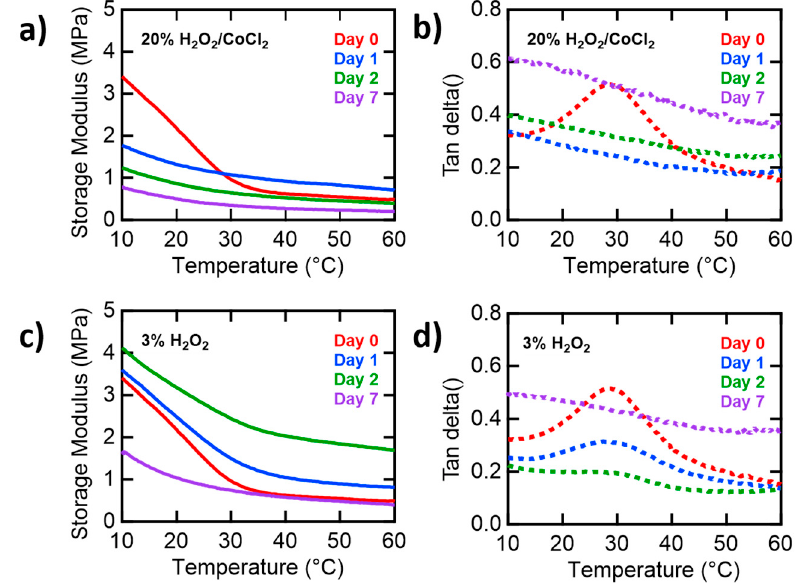
Figure 3. Effects of degradation on the viscoelastic properties of LCEs. ( a ) Storage Modulus (E’) as a function of temperature, comparing non-degraded films with films oxidized for 1, 2 and 7 days in 20% H 2 O 2 / CoCl 2 at 37 ◦ C. ( b ) Respective tan delta curve as a function of temperature. ( c ) Storage Modulus (E’) as a function of time for LCE films after exposure to 3% H 2 O 2 at 37 ◦ C for 1, 2 and 7 days and non-degraded films. ( d ) Respective curve of tan delta as a function of temperature.